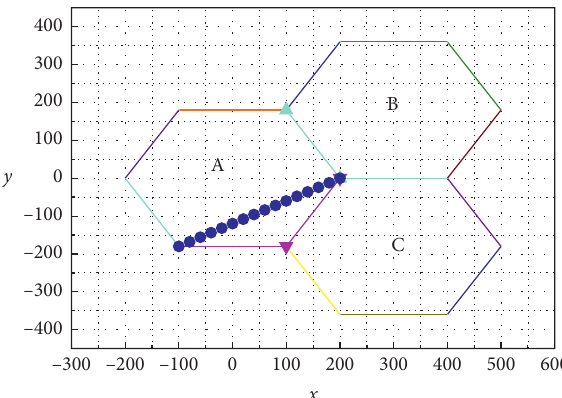
Figure 7: Composite indicator and average processing time for small